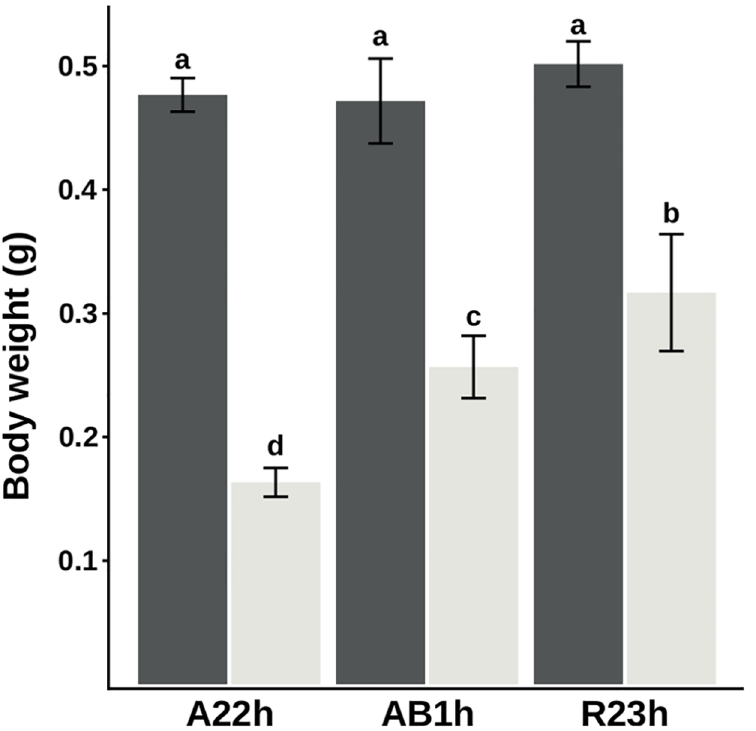
Fig 2. Mean body weights after 5 weeks of feeding. Final body weight (means ± SEM) of the three isogenic lines fed either a diet M (control diet in dark grey) or V diet (in light grey) after 5 weeks of feeding. Two-way analysis of variance, followed by a Tukey post hoc test were carried out in order to assess effects of diet and genotype. Different letters mean significance between groups (Cut-off P-value <